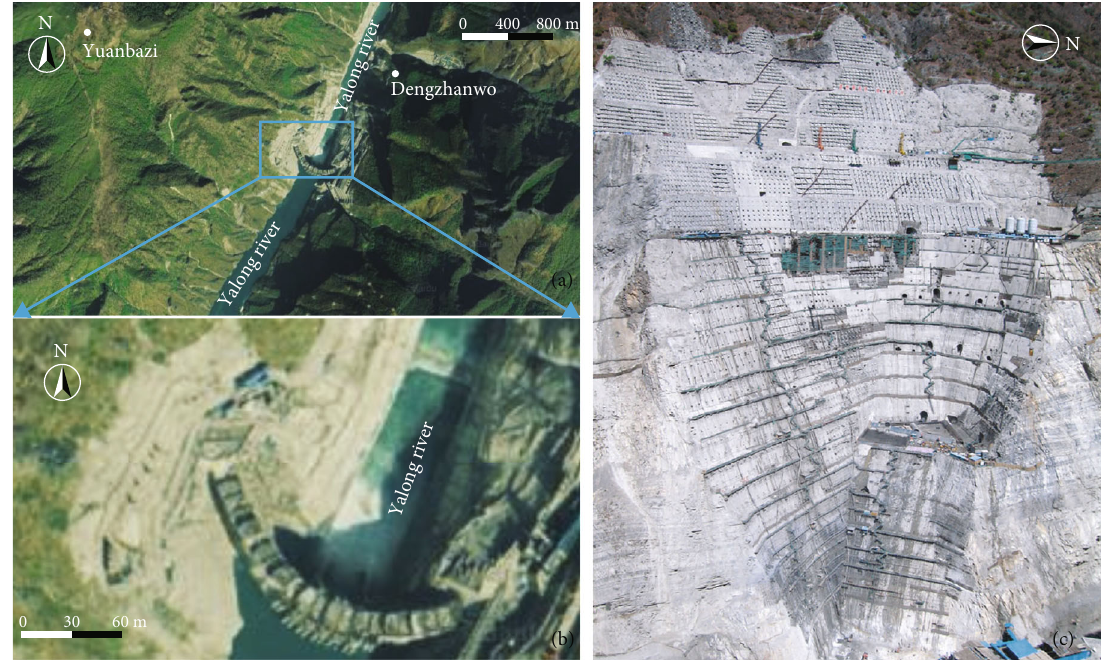
Figure 4: Overview pictures (captured from Google Earth) of the Jinping-1 dam site (a) and the left bank slope (b) and the photograph of the left bank slope after excavation (c) (modi fi ed from Xu et al. [36]). Table 1: The source parameters of the twelve microseismic events that occurred along the key block.